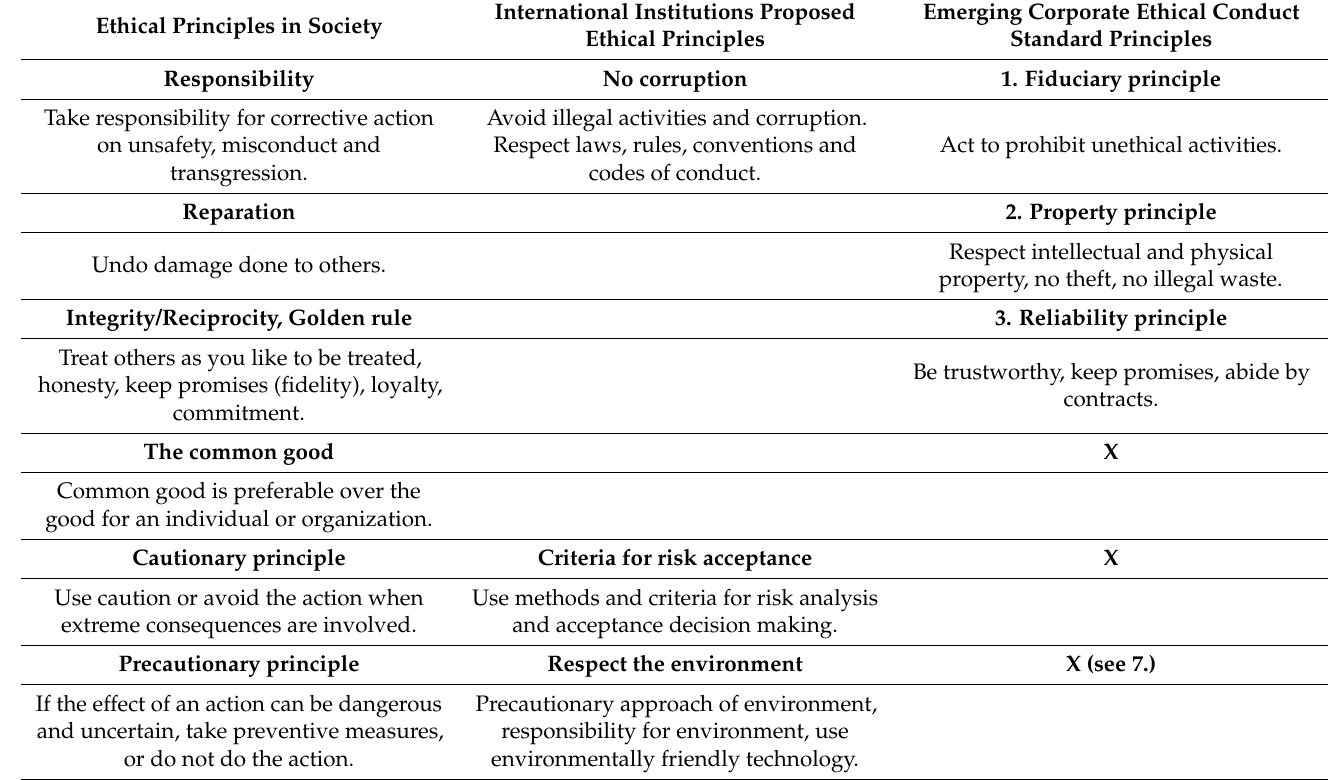
Table 1. Ethical principles and emerging corporate conduct principles relevant to health and safety. Ethical Principles in